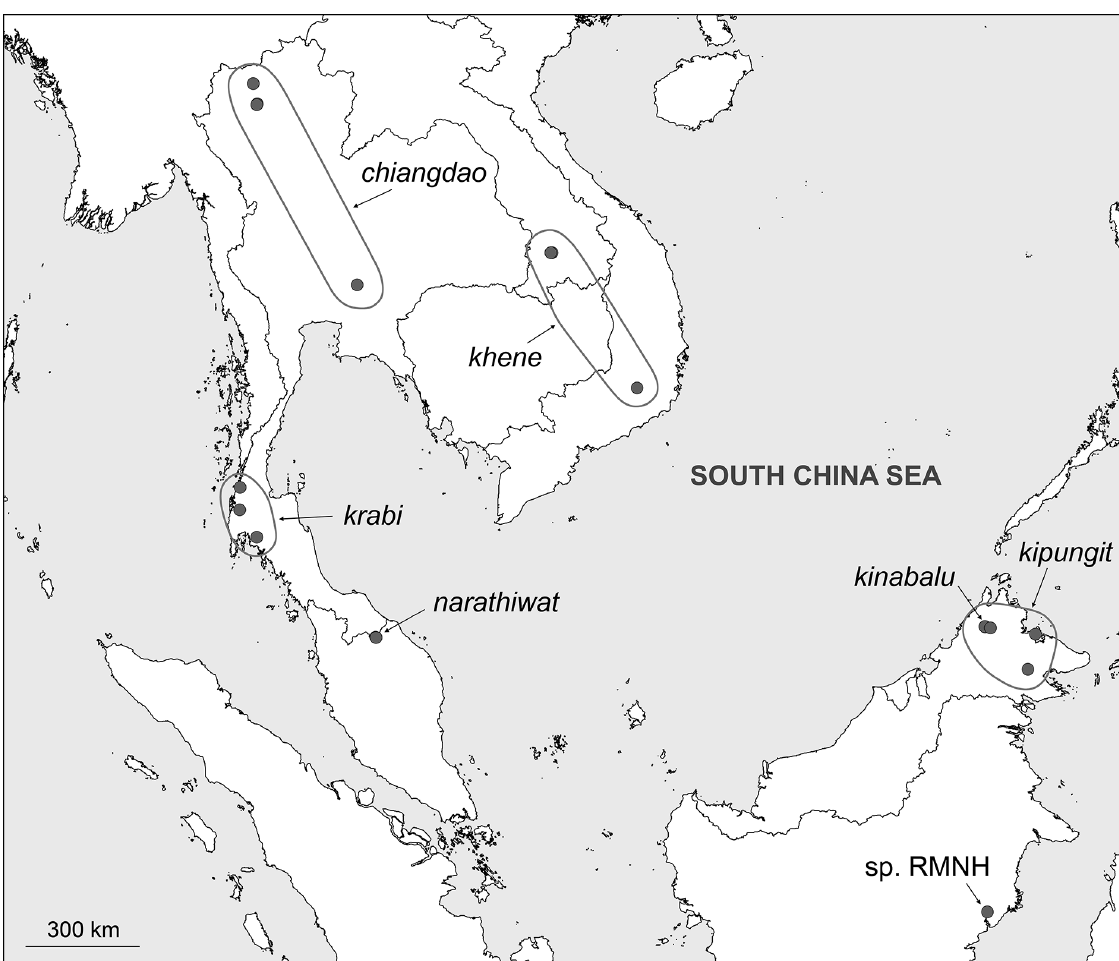
Fig. 110. Known distribution of the Pholcus krabi species